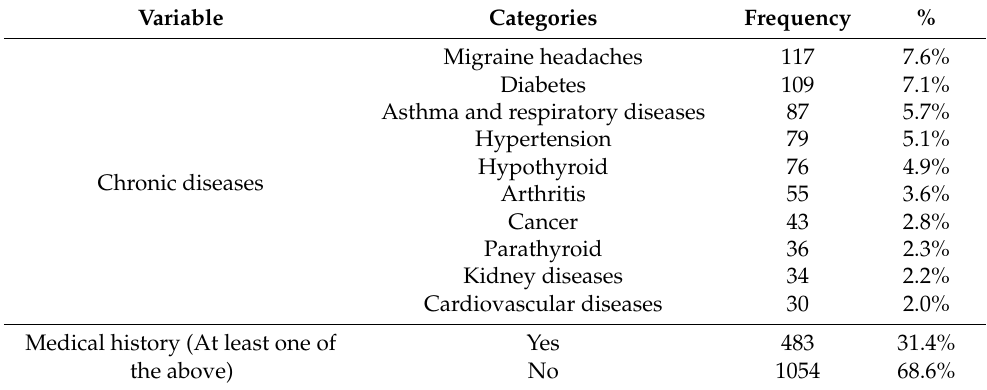
Table 2. Health history, vitamin D information source, and vitamin D testing, and supplementation ( n =